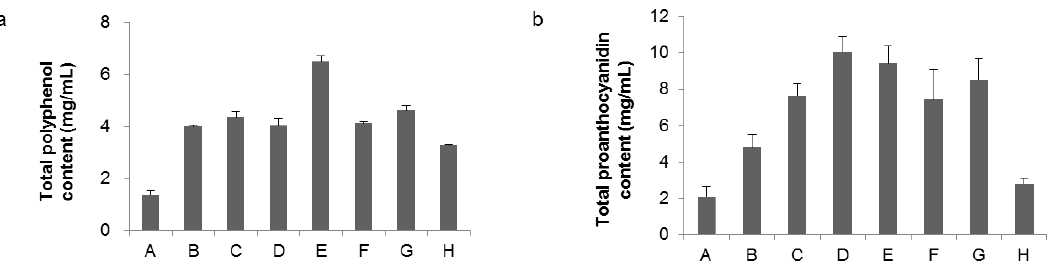
Figure 2. Total polyphenol and proanthocyanidin under different LED light treatment. ( a ) Total polyphenols were determined by the Folin–Ciocalteu method. Data are mg of gallic acid equivalent per 100 mg/mL DMSO solution of raspberry leaf extract; and ( b ) total proanthocyanidin was determined by a modified protein precipitation method. Data are mg of procyanidin B2 equivalent per 100 mg/mL DMSO solution of raspberry leaf extract. Error bars represent SD of the mean ( n = 4).